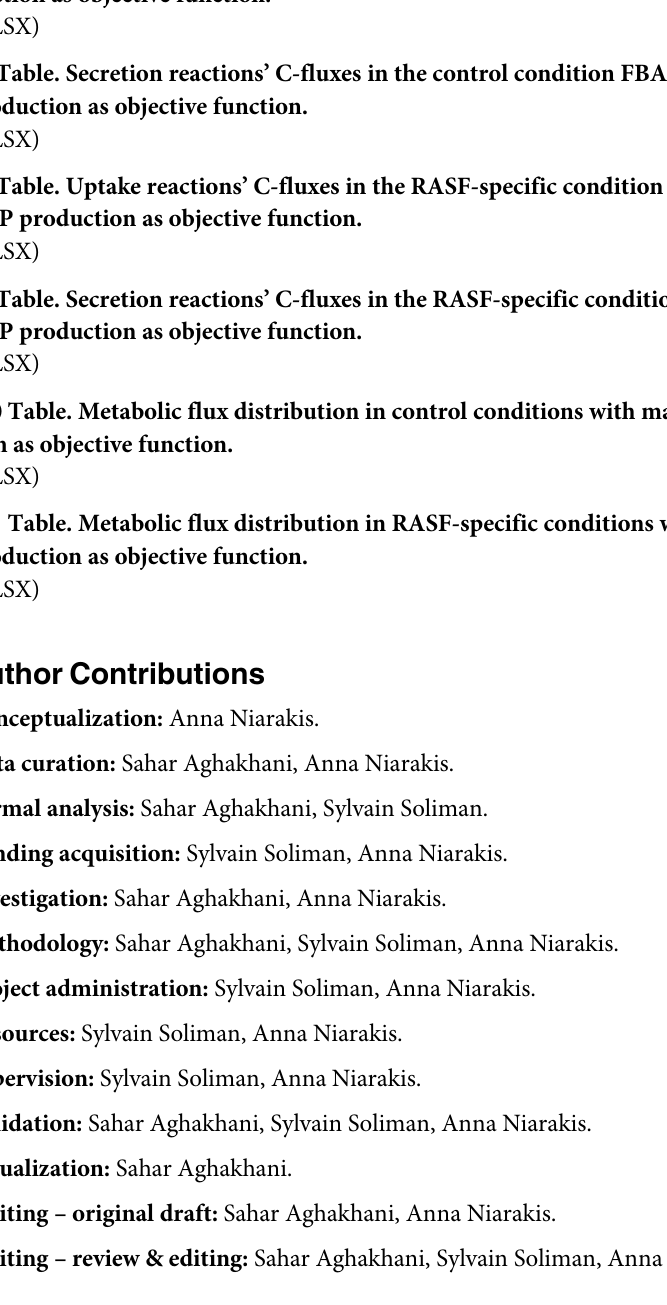
S5 Table. Metabolites’ projected maximal regulatory trap-space equal to 0 in RASF-spe- cific initial conditions and their associated producing reactions constrained to 0 in Mito- Core. S6 Table. Uptake reactions’ C-fluxes in the control condition FBA with maximal ATP pro- duction as objective function. S7 Table. Secretion reactions’ C-fluxes in the control condition FBA with maximal ATP production as objective function. S8 Table. Uptake reactions’ C-fluxes in the RASF-specific condition FBA with maximal ATP production as objective function. S9 Table. Secretion reactions’ C-fluxes in the RASF-specific condition FBA with maximal ATP production as objective function. S10 Table. Metabolic flux distribution in control conditions with maximal ATP produc- tion as objective function. S11 Table. Metabolic flux distribution in RASF-specific conditions with maximal ATP production as objective